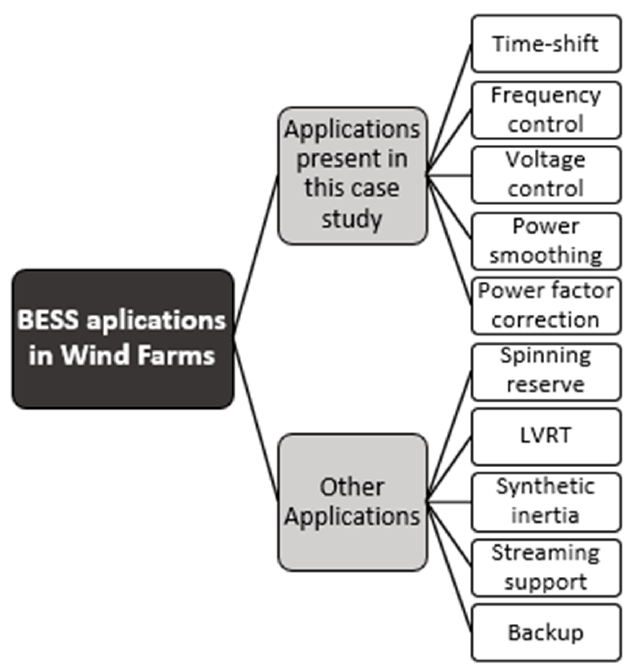
Figure 2. BESS applications in wind farms. Table 1. Description of BESS applications in wind farms .